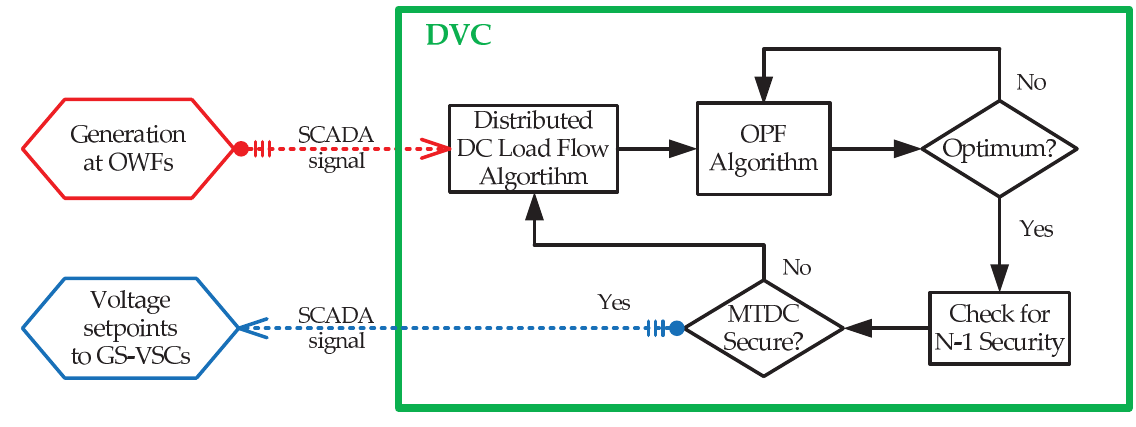
Figure 7. Flow chart of the distributed voltage control